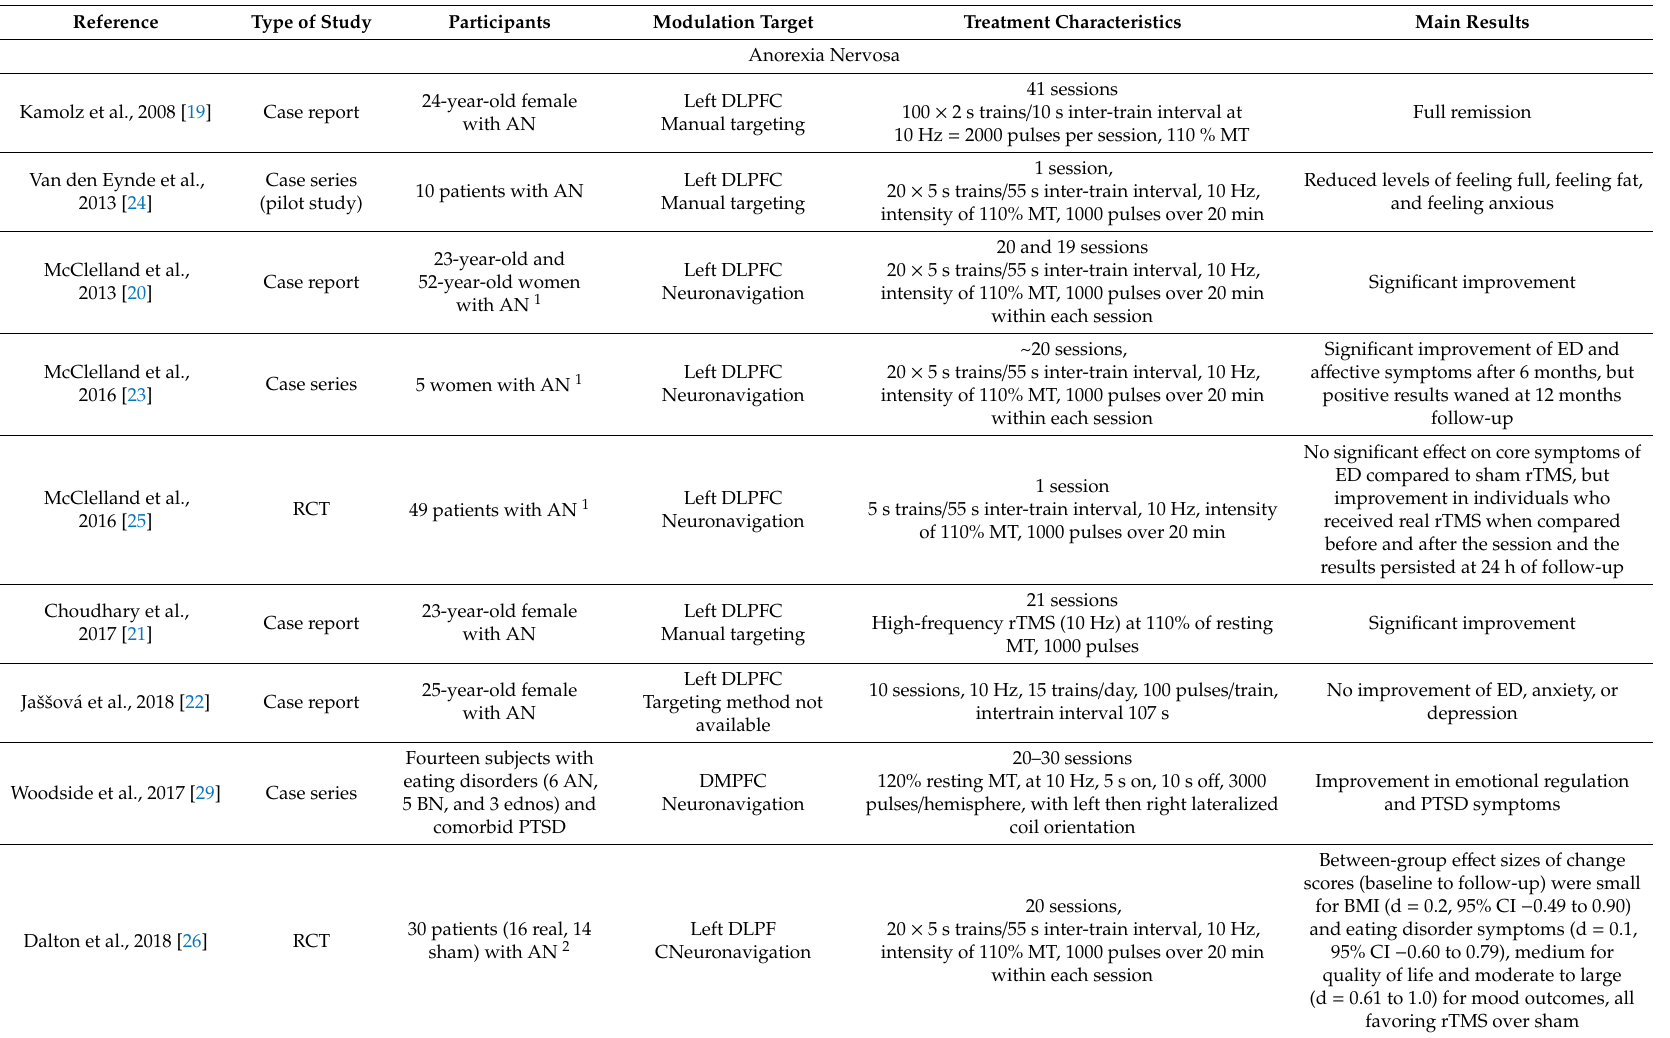
Table 1. Repetitive transcranial magnetic stimulation (rTMS) in eating